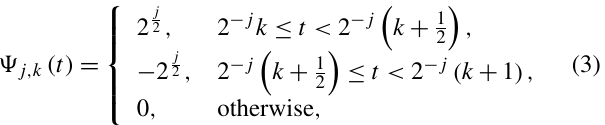
Cluster in the tail (hours and